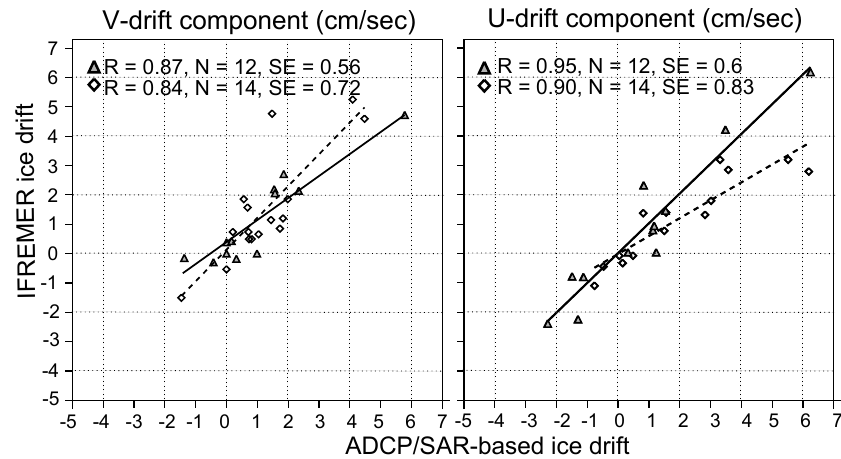
Fig. 2. Comparison between monthly mean Ifremer ice motion estimates and Envisat SAR (triangles) and ADCP based (diamonds) monthly mean ice drift. The U and V drift components are shown in the left and right panel, respectively. The solid and dashed line show the linear fit between Ifremer data and SAR and ADCP estimates. SAR motion information is based on a selection of scenes taken between 2006 and 2010 (December to April), while ADCP ice drift data originate from 3-yr round moorings (2007–2009) deployed in the vicinity of the fast ice edge. In addition, the correlation coefficient ( R ), number of samples ( N ), and standard deviation ( SE ) is given.